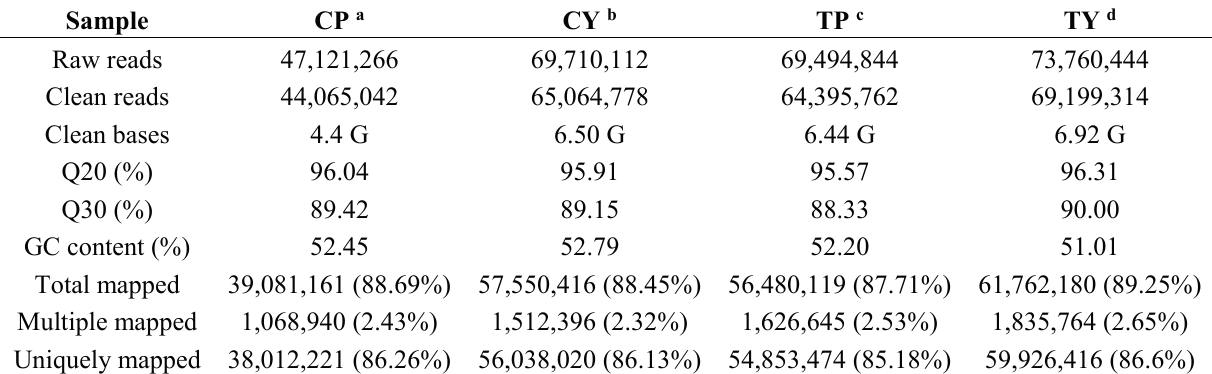
Table 1. Summary of sequencing data quality and the statistics of the transcriptome